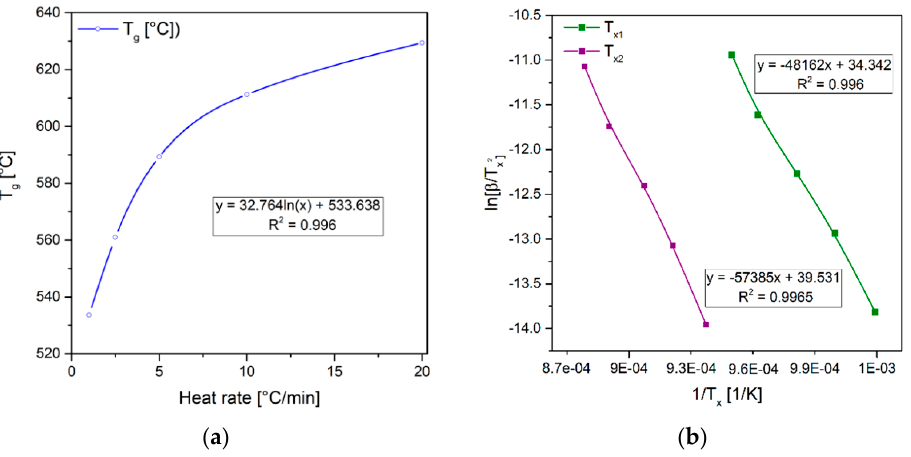
Figure 7. ( a ) Glass transition temperature T g as a function of the heating rate β and ( b ) the Kissinger function for the crystallization of 93GeO 2 –6Al 2 O 3 –1Bi 2 O 3 at temperatures T x1 and T x2 .